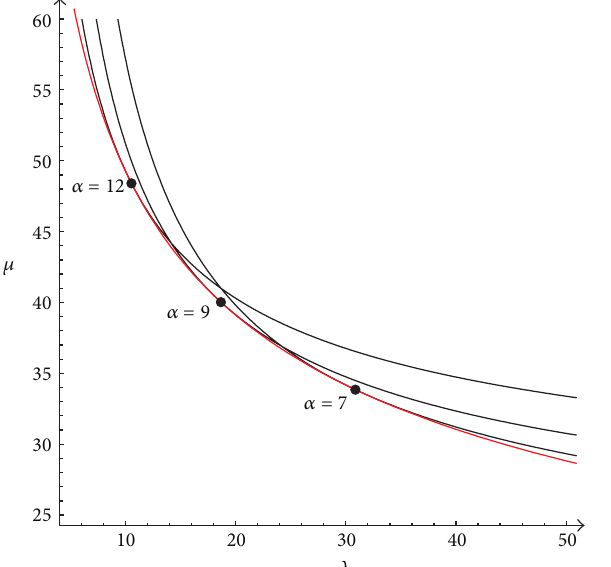
Figure 1: “Dead zone” beneath the envelope (in red) of branches 𝐹 ± 1 (𝛼) of the spectrum of the problems (3) and (4) for 𝑝 = 3 , 𝑞 = 1/3 and 𝛼 = 7, 9, 12 .